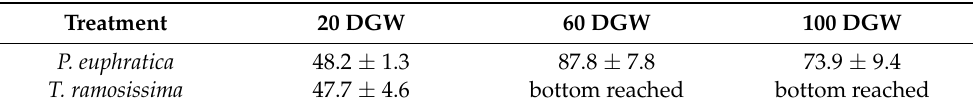
Table 1. Rooting depths (cm) of P. euphratica and T. ramosissima grown at 20 cm, 60 cm, and 100 cm groundwater depths (DGW). Values are means ± SE ( n = 3). Treatment 20 DGW 60 DGW 100 DGW P. euphratica 48.2 ± 1.3 87.8 ± 7.8 73.9 ± 9.4 T. ramosissima 47.7 ± 4.6 bottom reached bottom reached